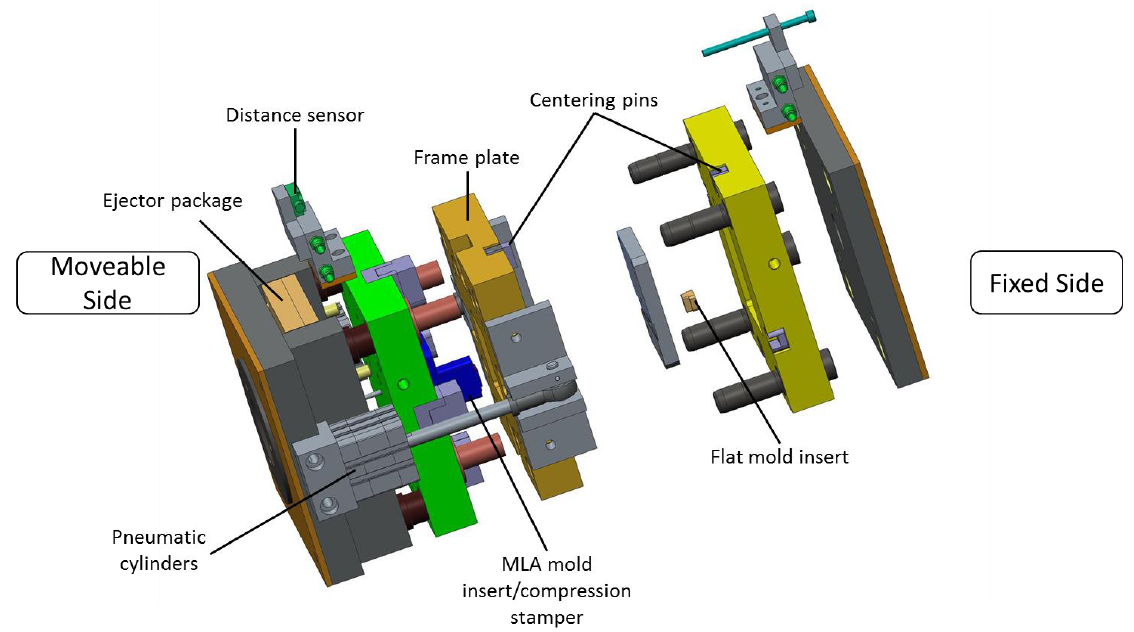
Figure 2. CAD drawing of the injection compression molding tool in an exploded view.